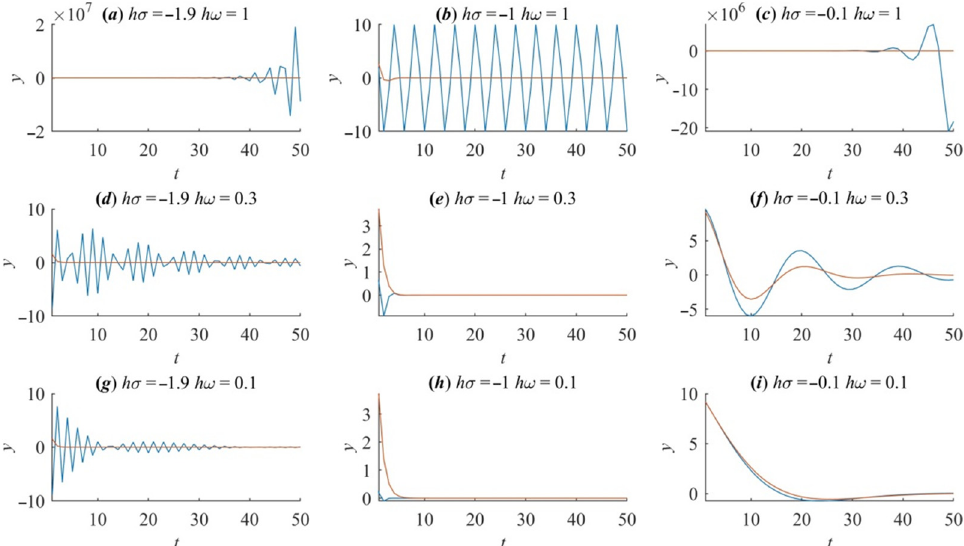
Figure 2. Solution graphs obtained for the proposed test problem (3) in nine test points shown in Figure 1. The blue line is x 1, n obtained by the Euler method. The red line is a reference solution for x 1, n found using the ode78 solver in MATLAB